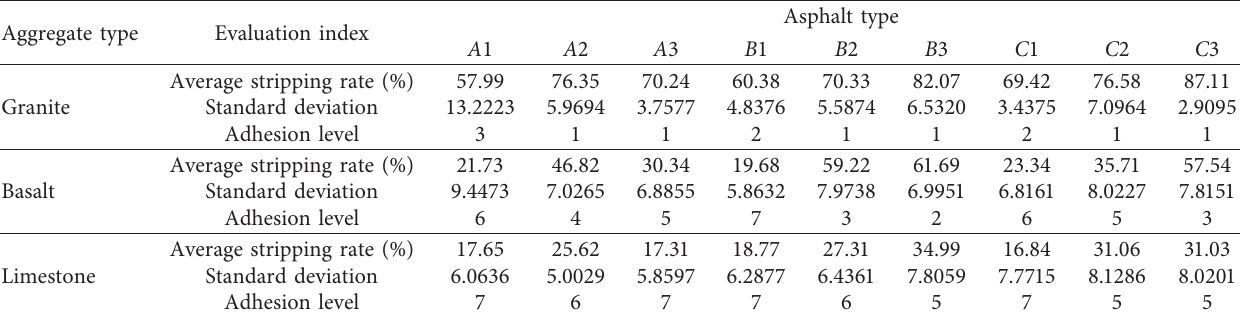
Table 10: Stripping rate of asphalt on the aggregate surface and the adhesion